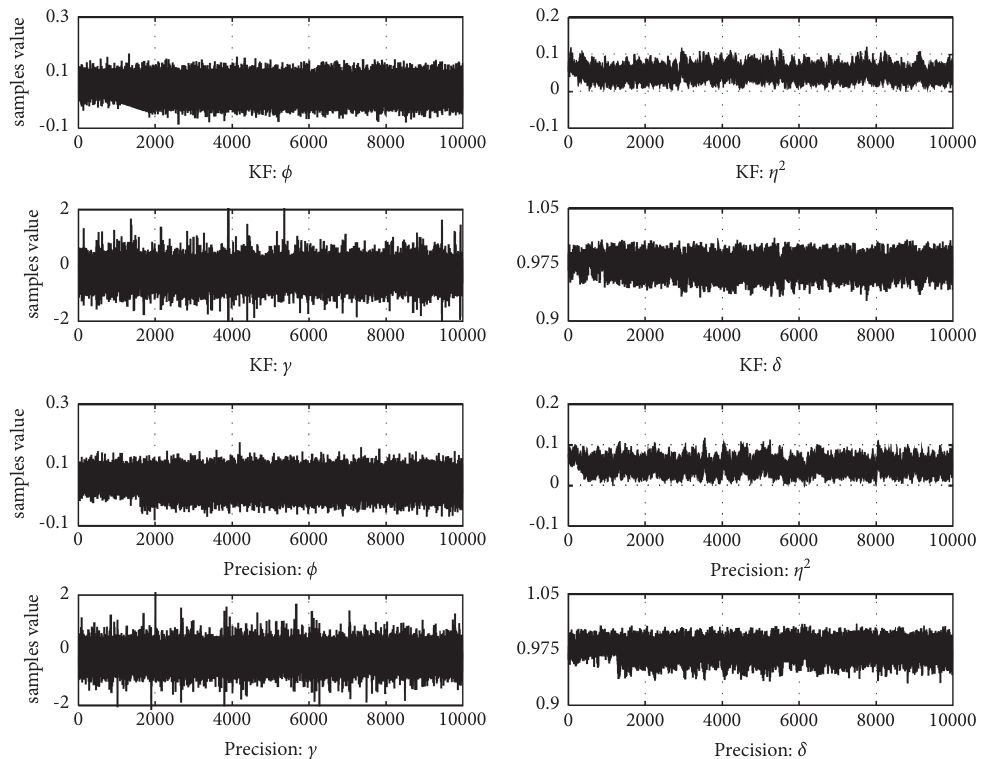
Figure 5: The sample paths of the parameters in the SVM